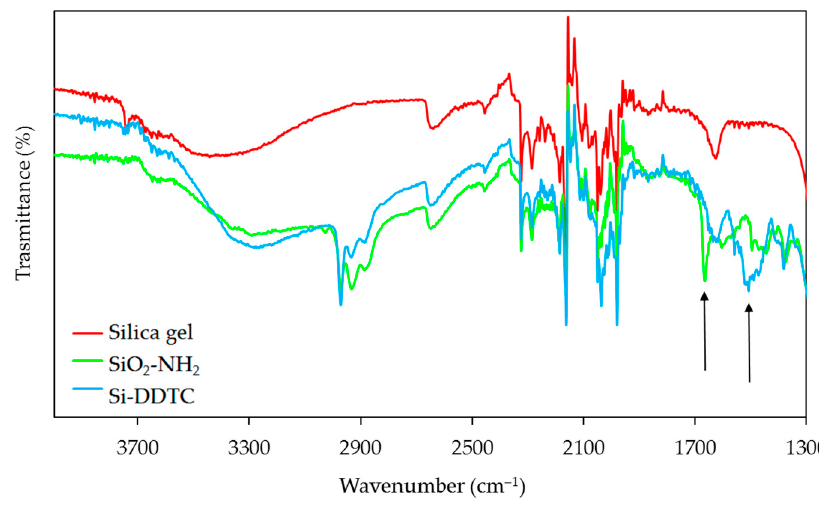
Figure 1. FT-IR spectra of: (red) silica gel, (green) SiO 2 -NH 2 , and (blue) Si-DTC. The arrows at 1663 cm − 1 and 1507 cm − 1 indicate the NH 2 and N-CS 2 vibration of the SiO 2 -NH 2 and Si-DTC, respectively.